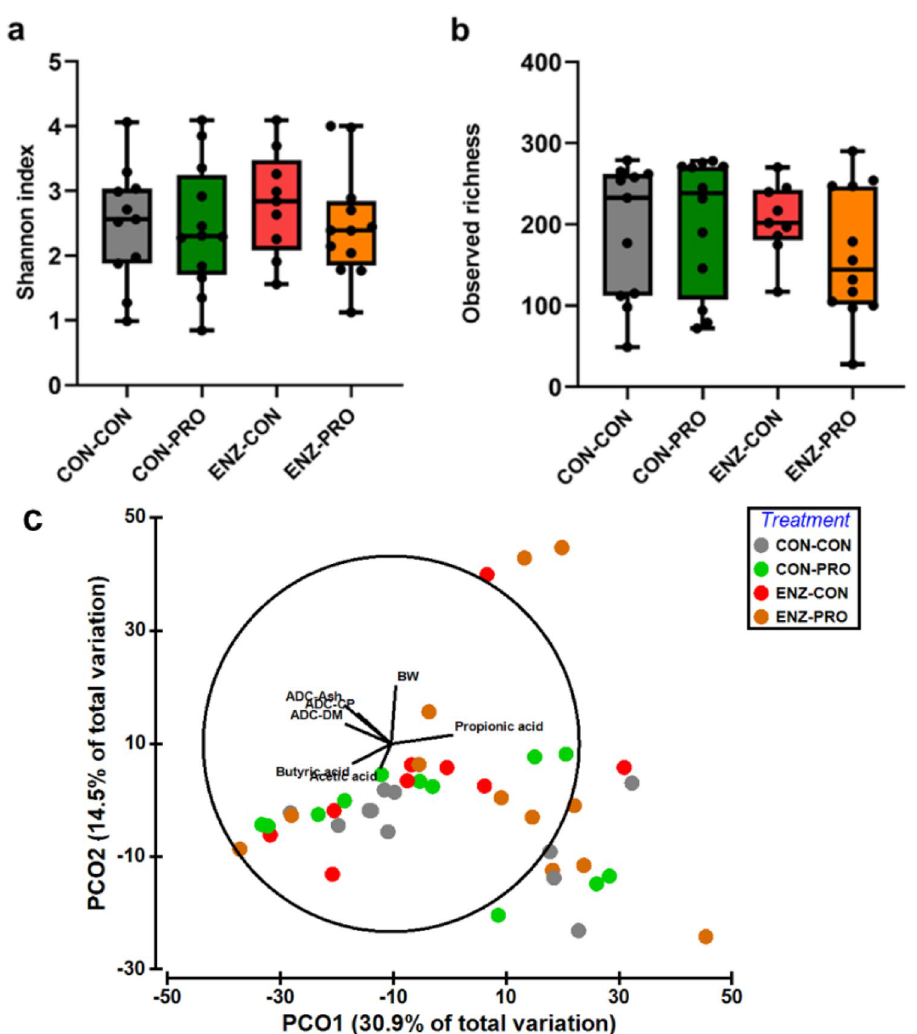
Figure 4. Microbial diversity in the distal gut of Nile tilapia. ( a ) Shannon index, ( b ) observed richness, and structure shown by ( c ) PCoA analysis based on Bray–Curtis distance and the correlation between microbial community structure and growth-related parameters. BW, body weight, ADC, apparent digestibility coefficient. Acetic acid, butyric acid and propionic acid are the concentrations from the distal gut. CON-CON, no enzymes or probiotics added; CON-PRO, probiotics added; ENZ-CON, enzymes added; ENZ-PRO, enzymes and probiotics